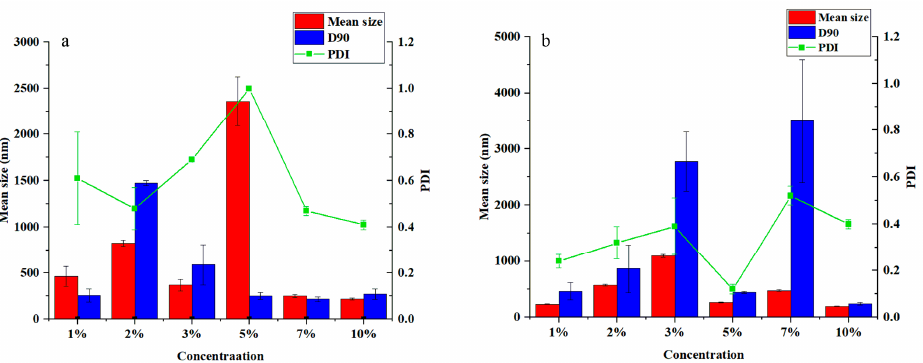
Figure 4. Effect of different emulsifier concentrations on nanocapsule size and PDI with Solvesso a ) Tween 80, ( b ) Emulsifier 100 as the solvent: ( a ) Tween 80, ( b ) Emulsifier 600#. as the solvent: (